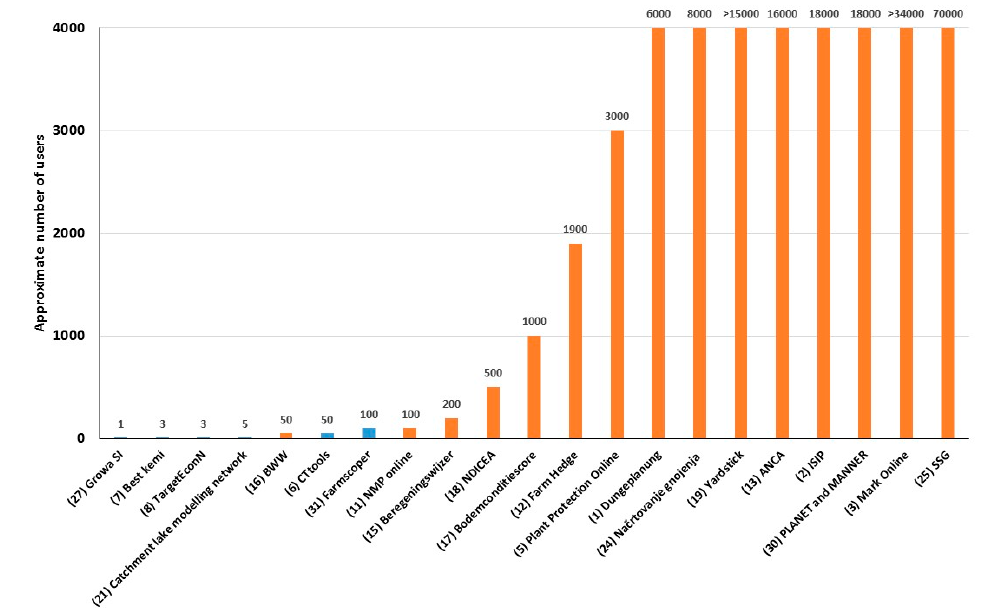
Figure 3. Approximate number of users of the shortlisted DSTs (where data was available). Numbers in brackets on the x-axis refer to the DST number in Table A3.